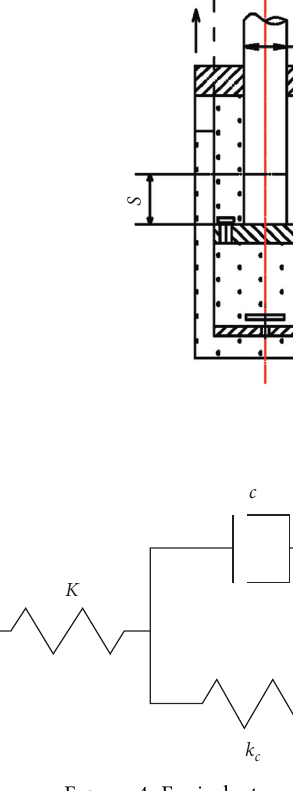
Figure 4: Equivalent parameter